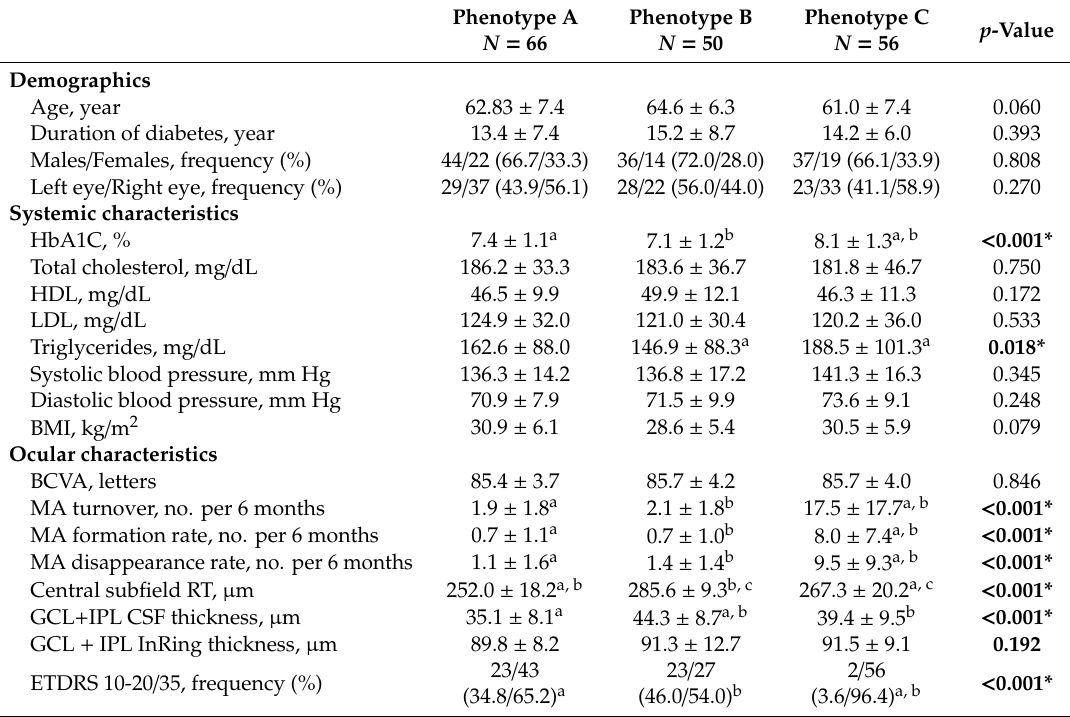
Table 2. Characteristics of each phenotype at baseline ( n =